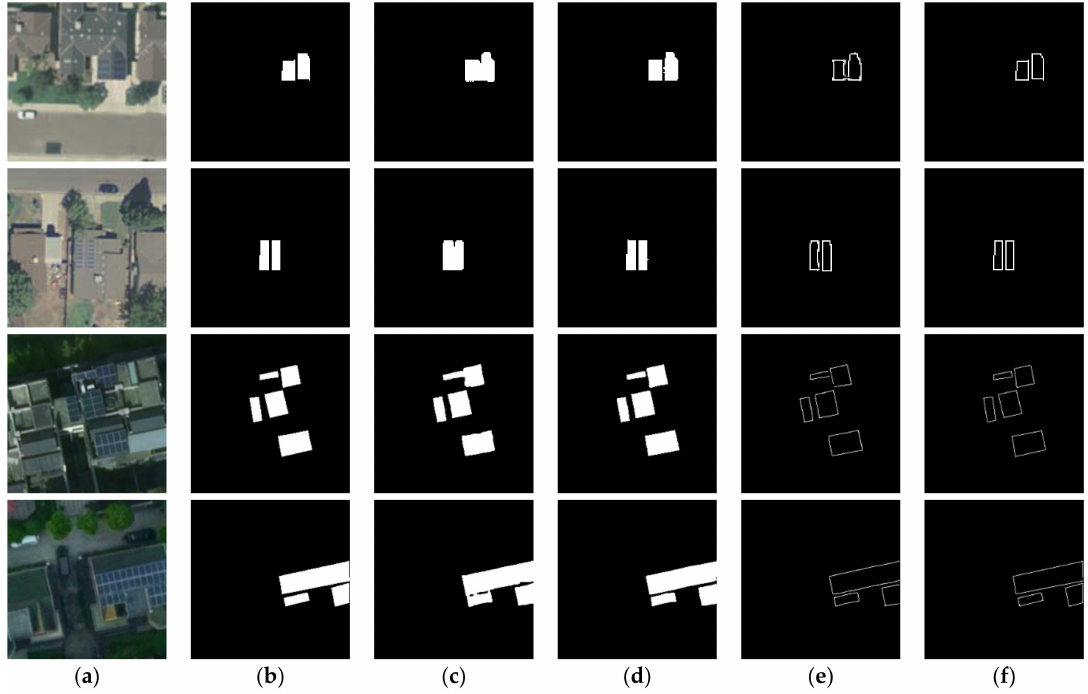
Figure 10. Resultsamplesbeforeandafteraddingtheedgedetectionnetwork: ( a )Image; ( b )segmentation label; ( c ) Effi-UNet + GFM results; ( d ) Effi-UNet + GFM + EDN segmentation results; ( e ) Effi-UNet + GFM + EDN edge detection results; ( f ) edge